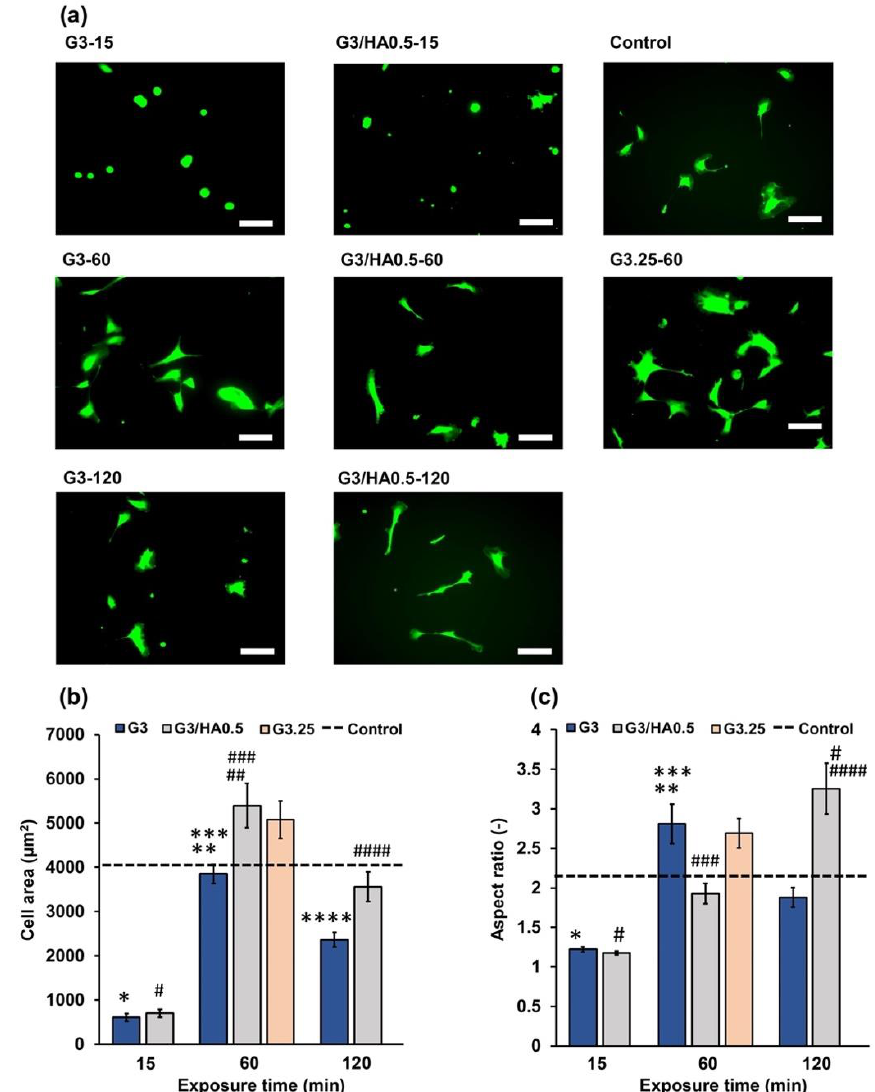
Figure 6. ( a ) Fluorescence micrographs of HUVECs stained with calcein-AM after 2 days of post culture on the G3, G3/HA0.5, and G3.25 hydrogels. HUVECs cultured on the polystyrene cell culture plate are considered as the control, and the dashed line indicates the corresponding values for the control. Effect of the exposure time to the air containing 16 ppm H 2 O 2 on the ( b ) cell area and ( c ) aspect ratio of HUVECs on G3, G3/HA0.5, and G3.25 hydrogels. Scale bar:100 μm. Bars: S.E. ( n ≥ 35 cells). * p < 0.01, # p < 0.01, 15 min exposure time compared to control (cell area); * p < 0.01, # p < 0.01, 15 min and 120 min exposure time compared to control (aspect ratio); ** p < 0.01, ## p < 0.01, 15 min exposure time compared to 60 min (cell area); ** p < 0.01, 15 min exposure time compared to 60 min (aspect ratio); *** p < 0.01, ### p < 0.01, 60 min compared to 120 min; **** p < 0.05, #### p < 0.01, 15 min compared to 120 min (cell area); #### p < 0.01, 15 min compared to 120 min (aspect ratio). Tukey HSD. Previous studies have reported that the low-molecular-weight HA (LMW-HA) could induce cell elongation [37] and epithelial-to-mesenchymal transition (EMT) [38]. The EMT process involves a physiological transition marked by morphological changes to elon- gated spindle-like morphology. As shown in Figures 4 and S2b, prolonged exposure to air containing H 2 O 2 could degrade the HA-Ph. The degraded fragments of HA-Ph might in- teract with cell receptors that induce cell elongation [37]. In our previous study, similar result was obtained with mouse mammary cells cultured on the composite hydrogel (Gel- atin-Ph/HA-Ph) obtained through 120 min of exposure to the air containing 16 ppm H 2 O 2